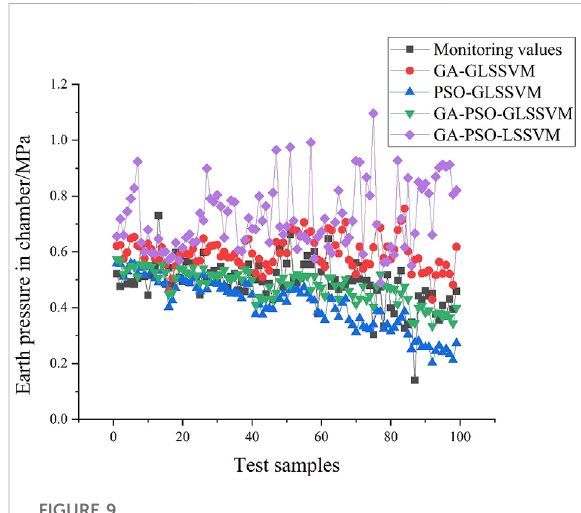
FIGURE 11 The prediction effect of GA-PSO-LSSVM model after eliminating the data with large fl uctuation.